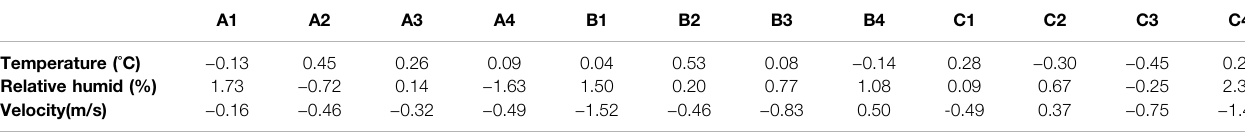
TABLE 4 | Daily difference between measured and simulated values of meteorological